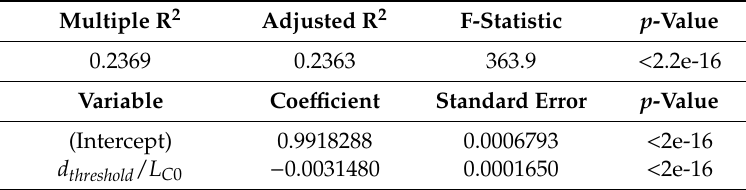
Figure 8. Changes in geometrical features resulting from simplification. Table 2. Regression analysis of Bhattacharyya coefficient.